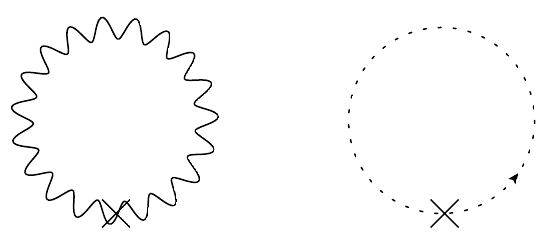
Figure 14 . The one-loop Feynman diagrams contributing to the one-loop energy-momentum tensor of a massless gauge field. The photon contribution is the diagram with wiggly lines and the ghost diagram is dashed and